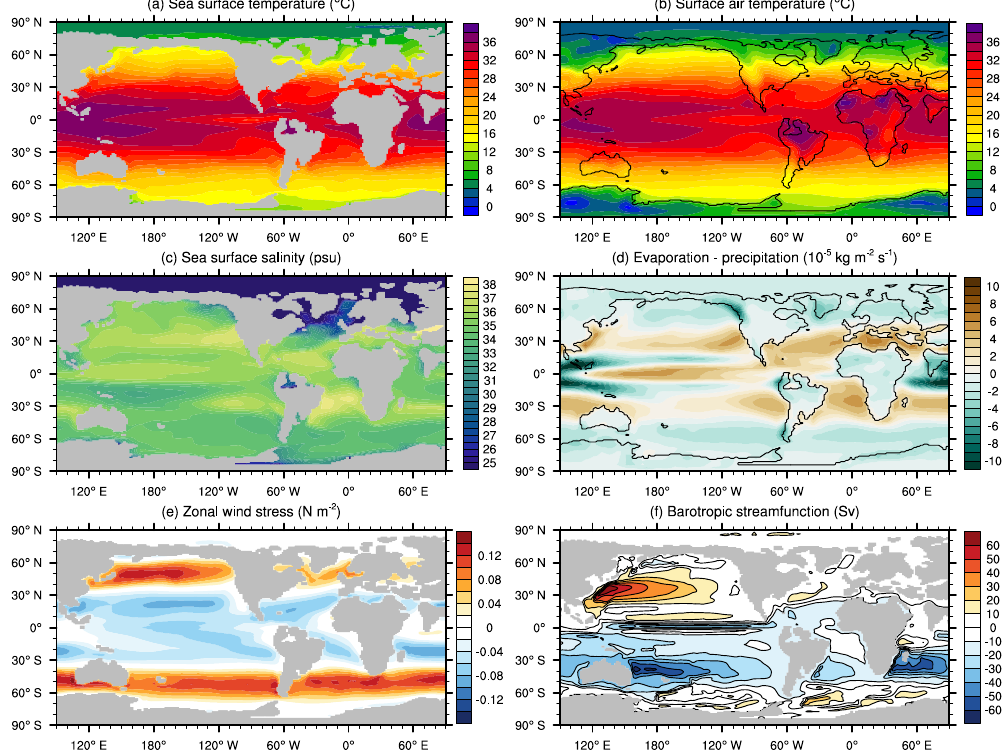
Figure 4. Control climate state at 800ppm, showing (a) sea surface temperature (SST), (b) surface air temperature (SAT), (c) sea surface salinity (SSS), (d) evaporation minus precipitation, (e) barotropic streamfunction and (f) zonal wind stress.